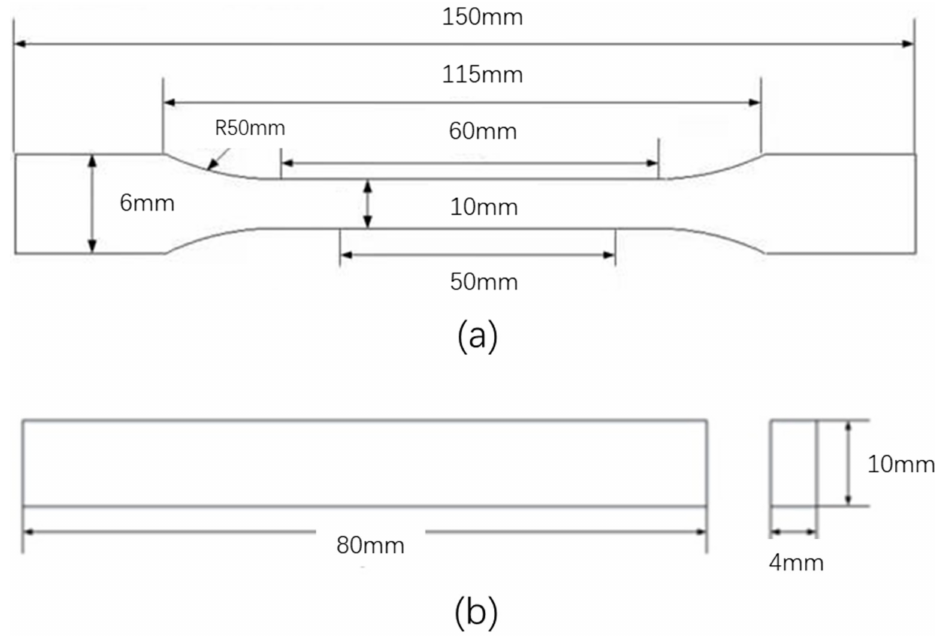
Figure 1. Dimensions of the specimens for ( a ) tensile test and ( b ) bending